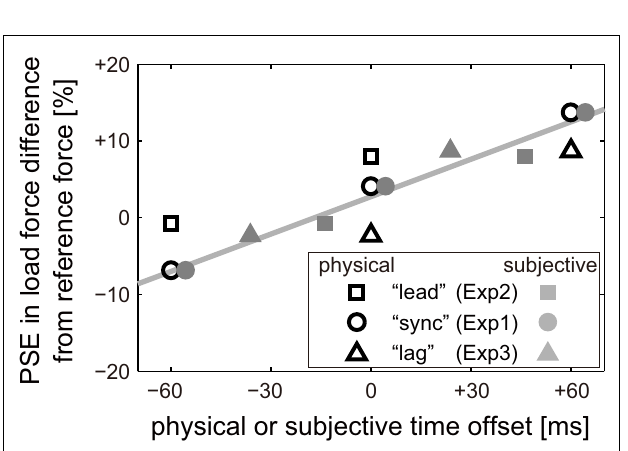
FIGURE 9 | Relationship between perceived weight and physical or subjective time offset. PSEs of group-average psychometric curves for weight judgments in all experiments are plotted with respect to actual (physical) time offsets as black unfilled marks. PSEs are also plotted as gray filled marks with respect to subjective time offsets (physical offset minus PSS of group-average psychometric curves for temporal simultaneity). Shapes of the marks represent the Conditioning sessions.The gray solid line is a linear regression of the gray marks.